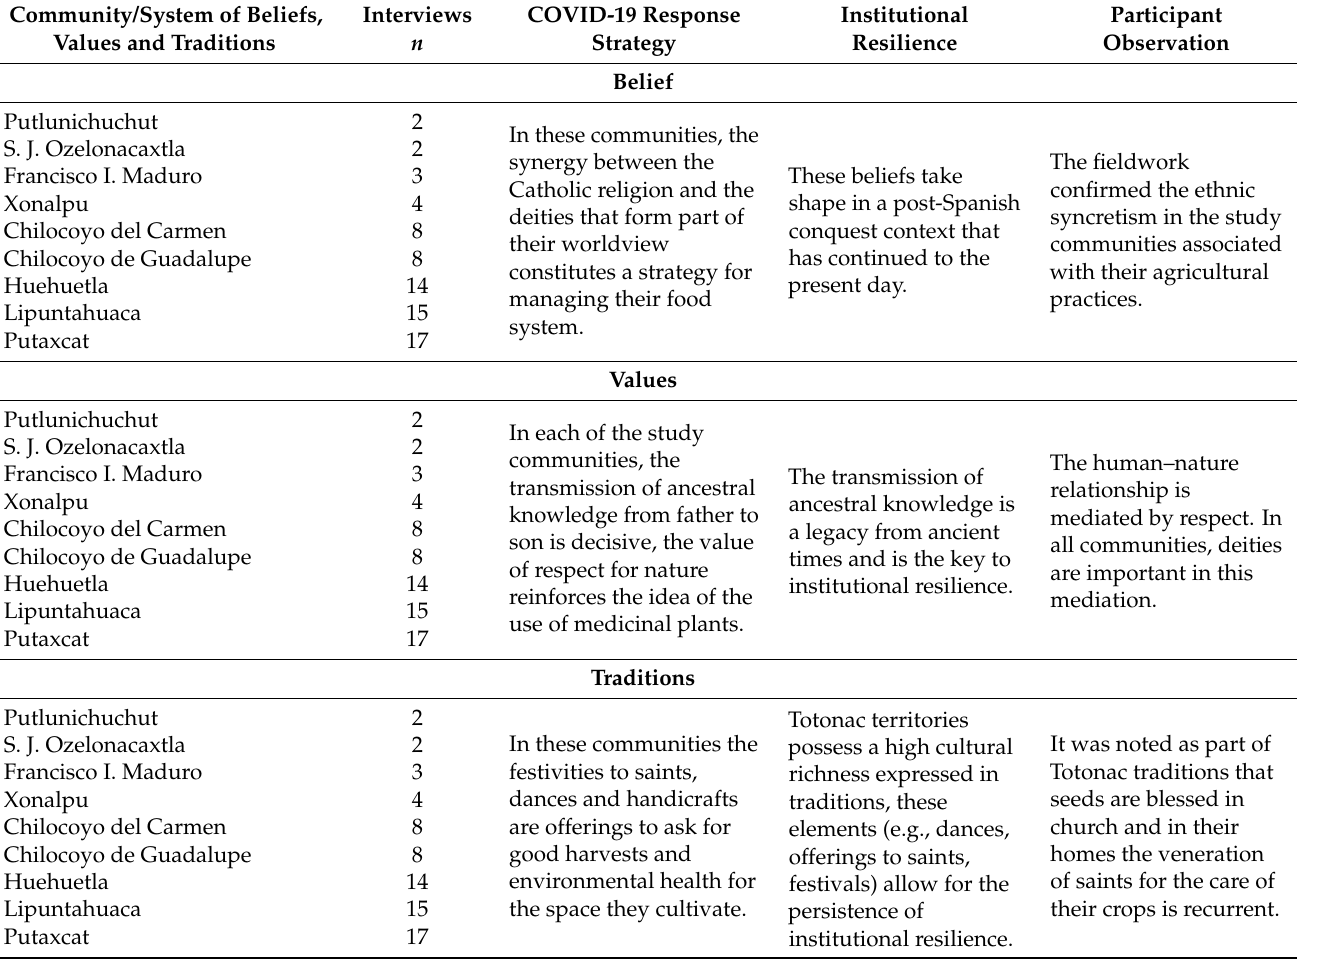
Table 1. Particularities of indigenous Totonac communities and their systems of beliefs, values and traditions. Community/System of Beliefs, Values and